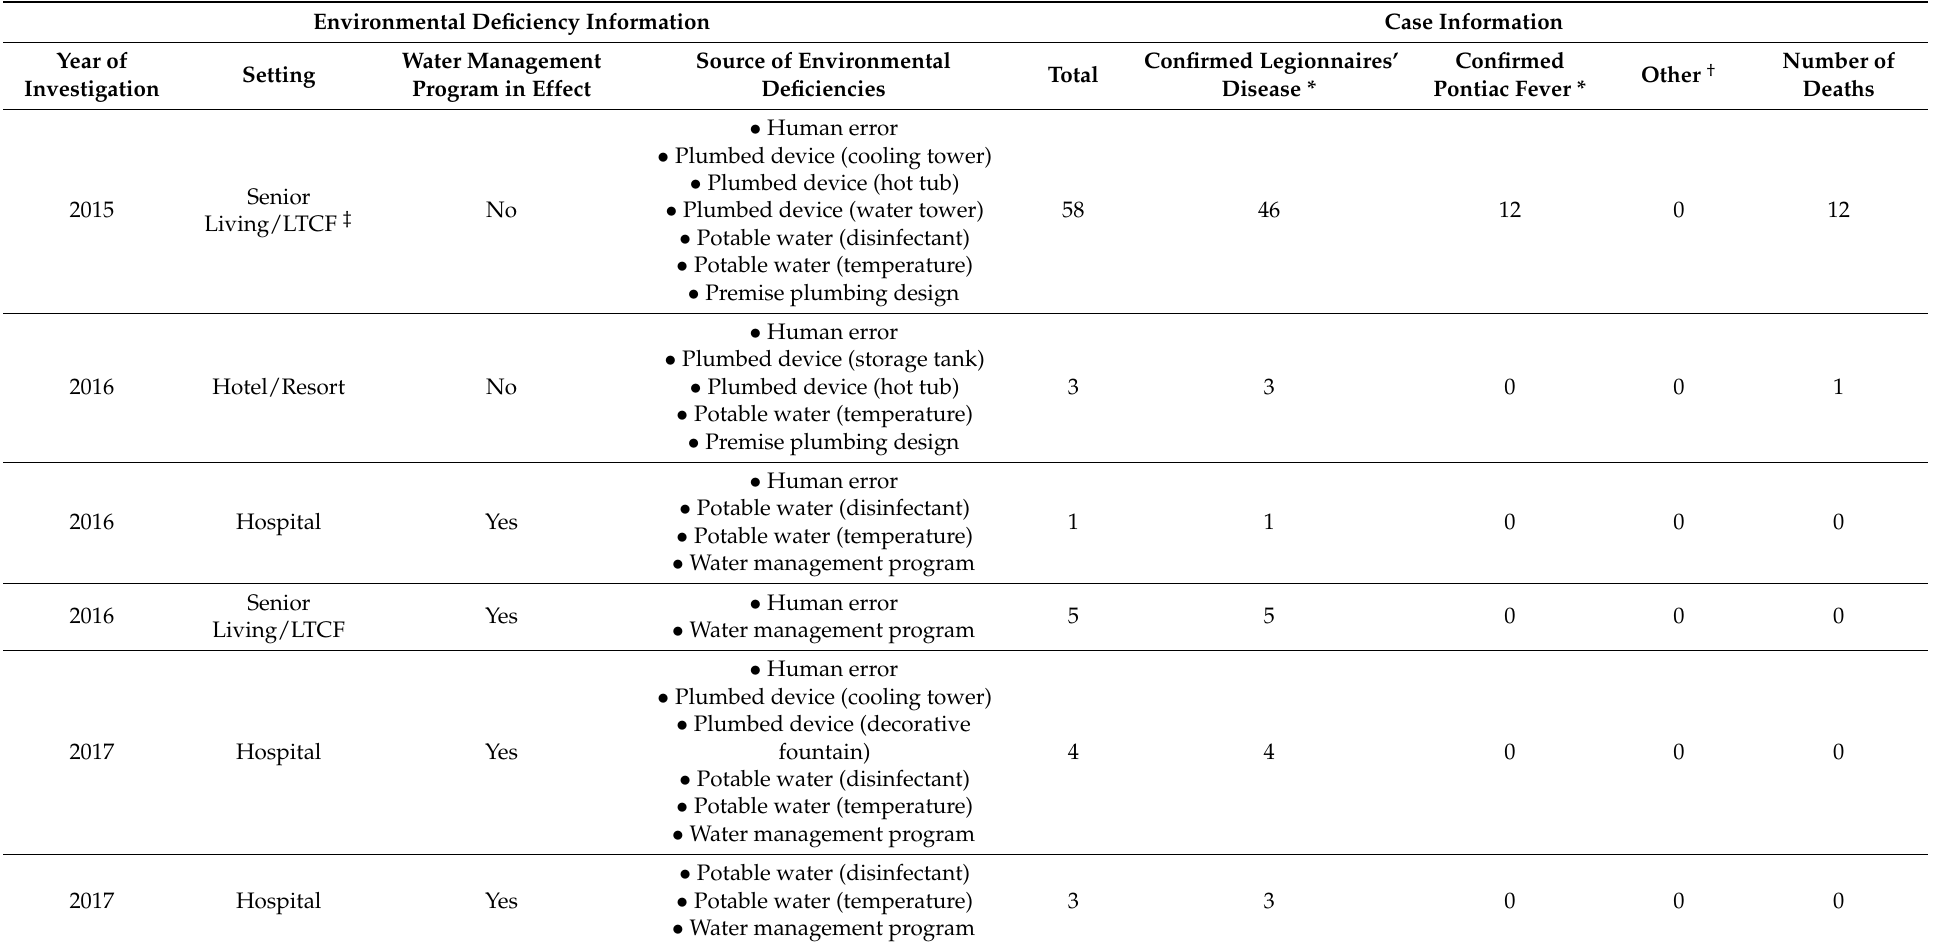
Table 1. Case and environmental deficiency information identified in outbreaks of Legionnaires’ disease investigated by the Centers for Disease Control and Prevention (CDC), 2015–2019 ( n =